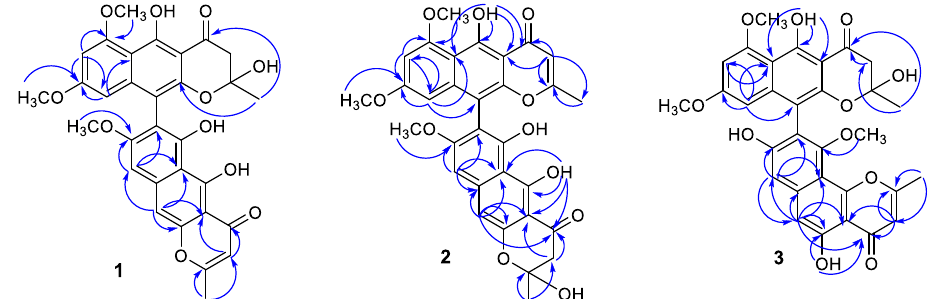
Figure 2. Selected HMBC correlations of teratopyrones A–C ( 1 – 3 ). Molecules 2020 , 25 , x